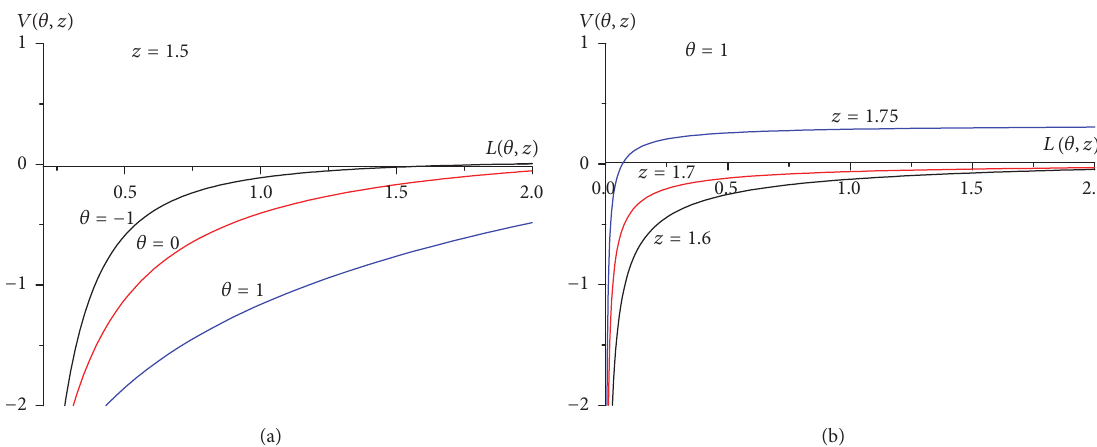
Figure 1: Plots of 𝑉(𝜃,𝑧) versus 𝐿(𝜃,𝑧) . (a) 𝑧 = 1.5 ; from top to bottom 𝜃 = −1, 0, 1 , respectively; (b) 𝜃 = 1 ; from top to bottom 𝑧 = 1.75, 1.7, 1.6 , respectively.